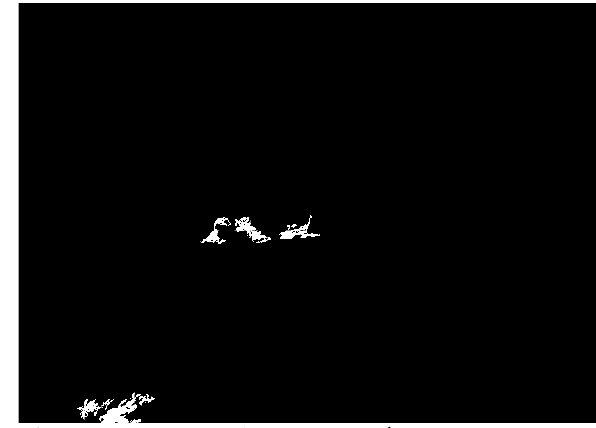
Figure 10. Post classification result (connected region area threshold: 600 pixels).